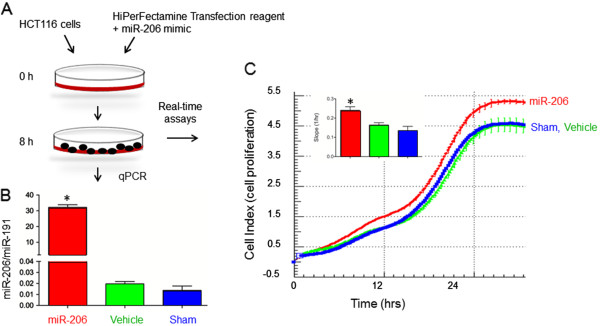
Cell proliferation is increased by miR-206. (A) Experimental protocol for the treatment of HCT116 cells. (B) qRT-PCR data confirmed upregulation of miR-206 expression. (C) Real-time monitoring assays using the xCELLigence system
[26]. Data bars indicate mean ± SD, n = 3.